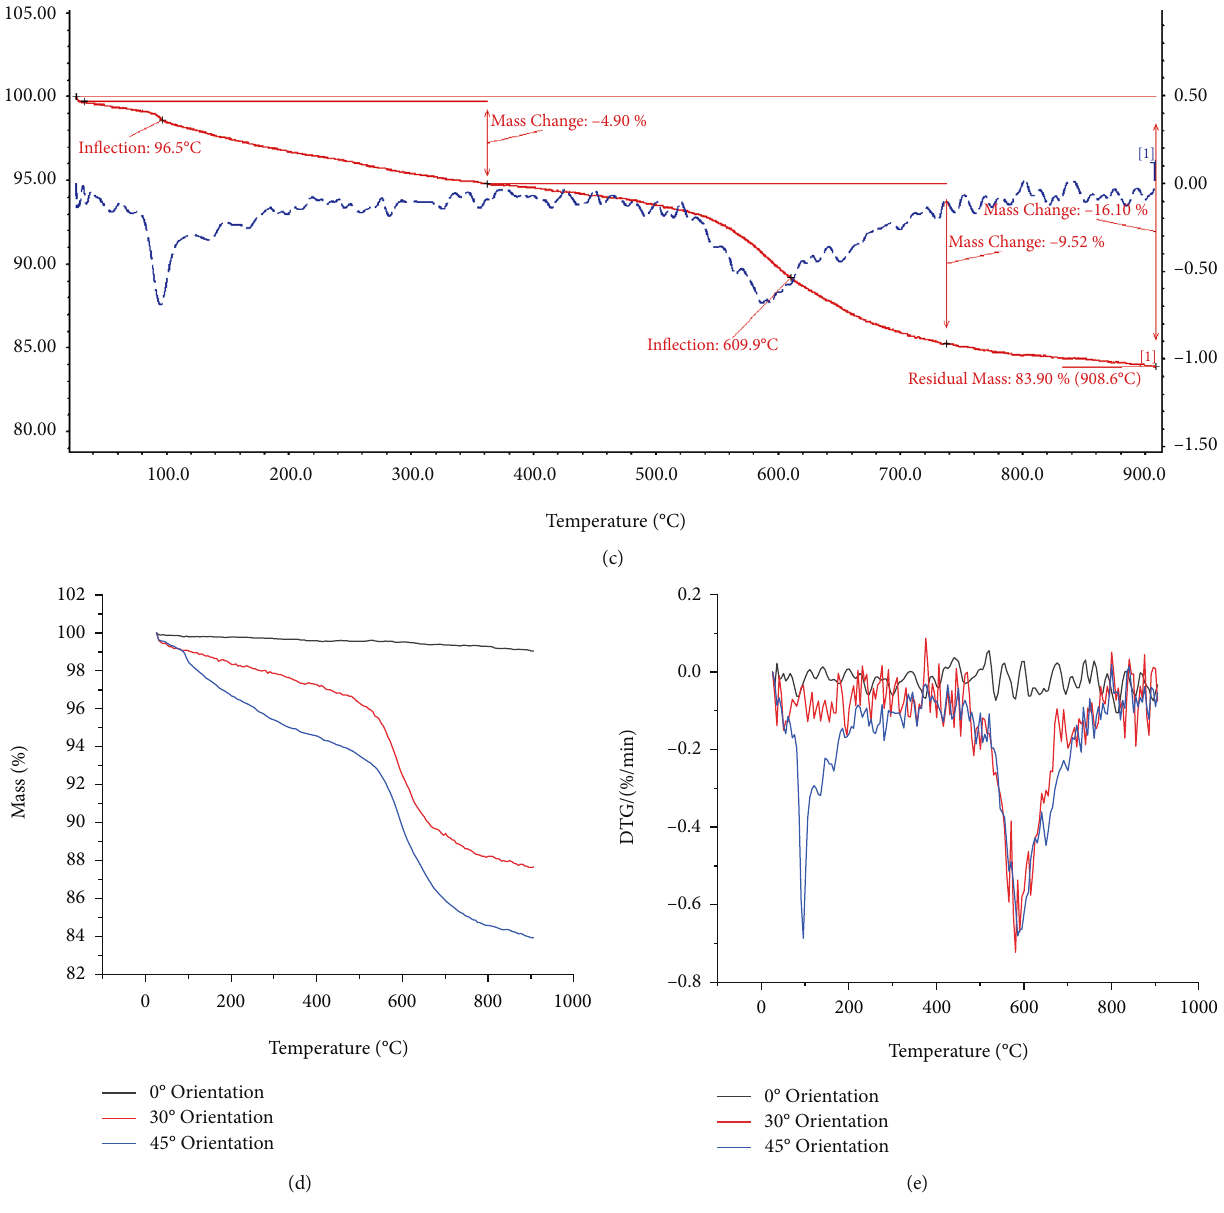
Figure 6: Thermal stability of basalt fi ber – reinforced anamide composites at (a) 0 ° orientation, (b) 30 ° orientation, (c) 45 ° orientation, (d) temperature versus residual mass for di ff erent orientations, and (e) temperature versus DTG for di ff erent